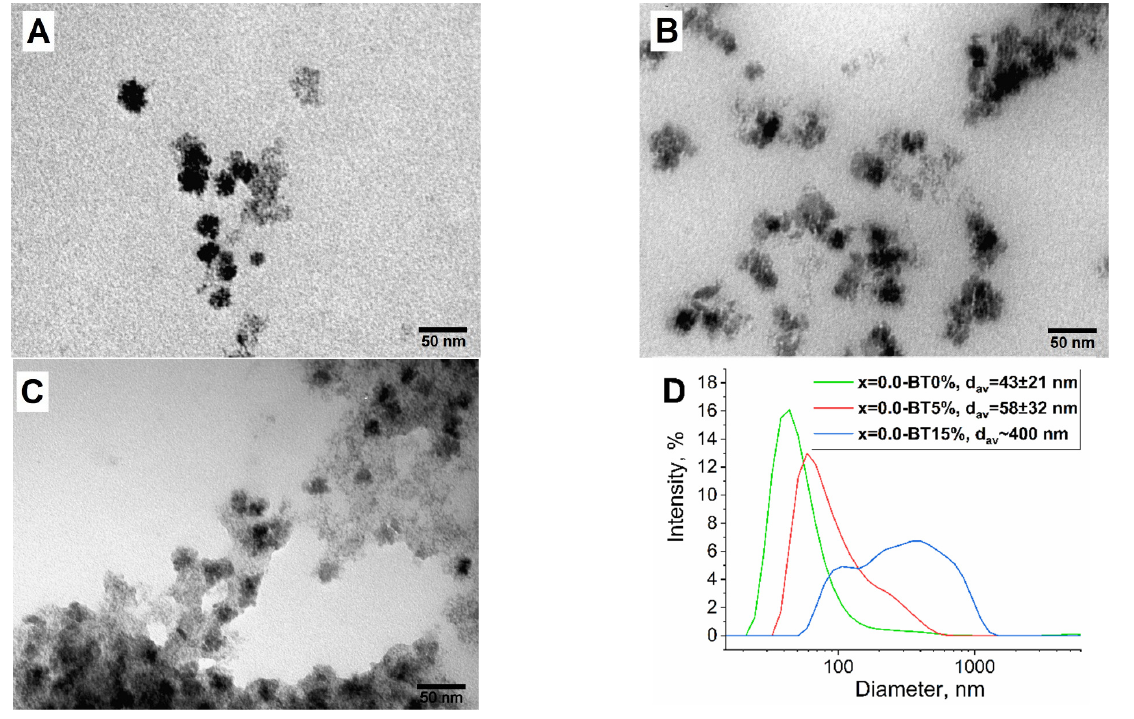
Figure 4. TEM and DLS data for the samples of x = 0.0-BT0% ( A ), x = 0.0-BT5% ( B ), x = 0.0-BT15% ( C ), and their hydrodynamic size ( D ).